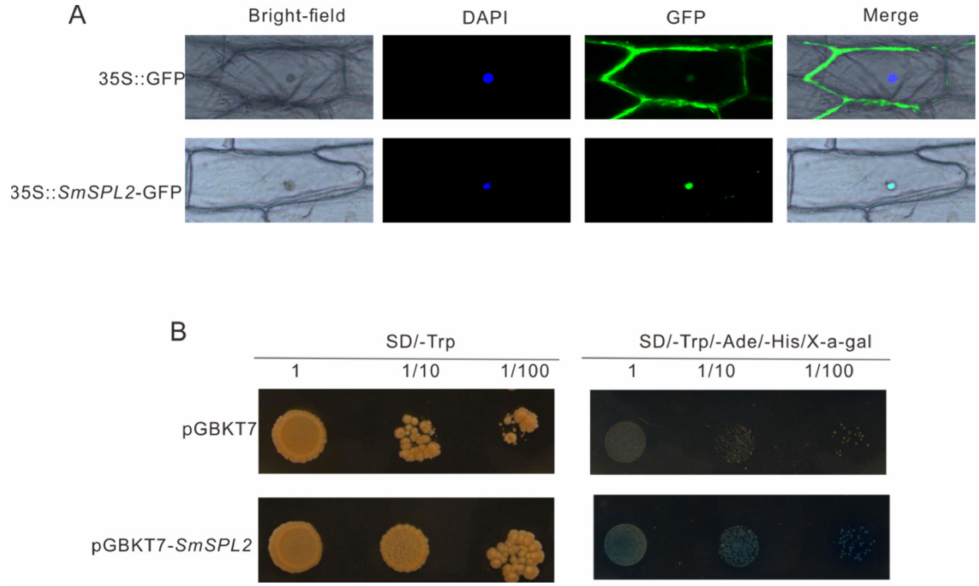
Figure 2. Subcellular location and transactivation activity analysis of SmSPL2 protein. ( A ) Subcellular location of SmSPL2 in onion epidermal cells. The fluorescence signal was observed via a laser scanning confocal microscope. DAPI, 4 (cid:48) ,6-diamidino-2-phenylindole is a blue-fluorescent DNA stain used to indicate the nucleus region. ( B ) Transcriptional activation analysis of SmSPL2 protein. Yeast colonies with three different dilutions were cultured on SD/-Trp and SD/-Trp/-Ade/-His/X- α -gal media. X- α -gal: 5-Bromo-4-chloro-3-indolyl- α -D-galactoside medium, the color reaction substrate of α